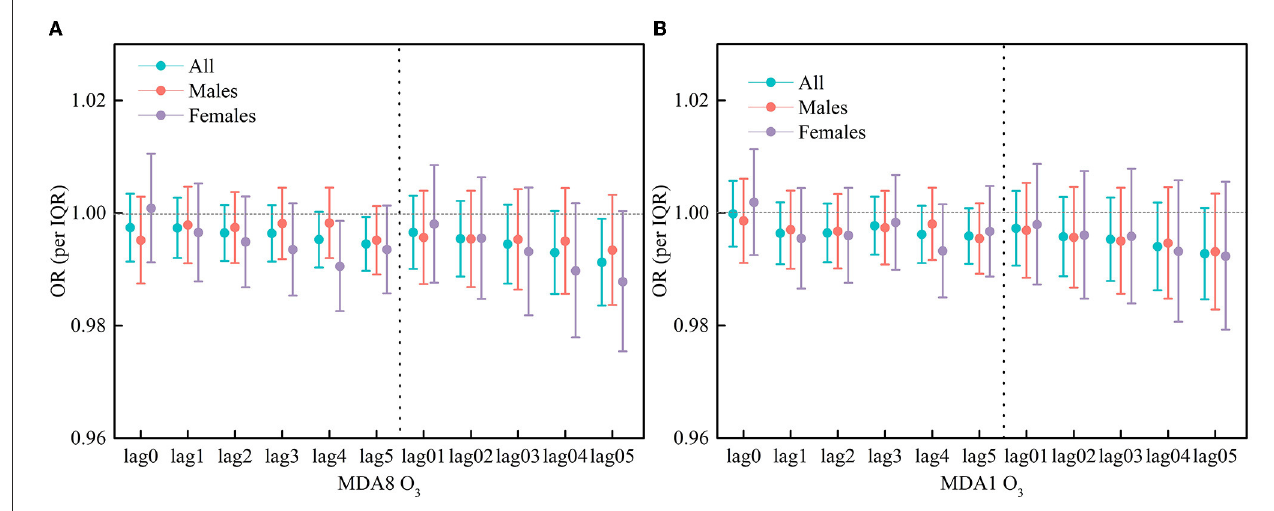
FIGURE3 OR of respiratory hospitalization visits in different gender group for per IQR increase in MDA8 O3 (A) and MDA1 O3 (B) .